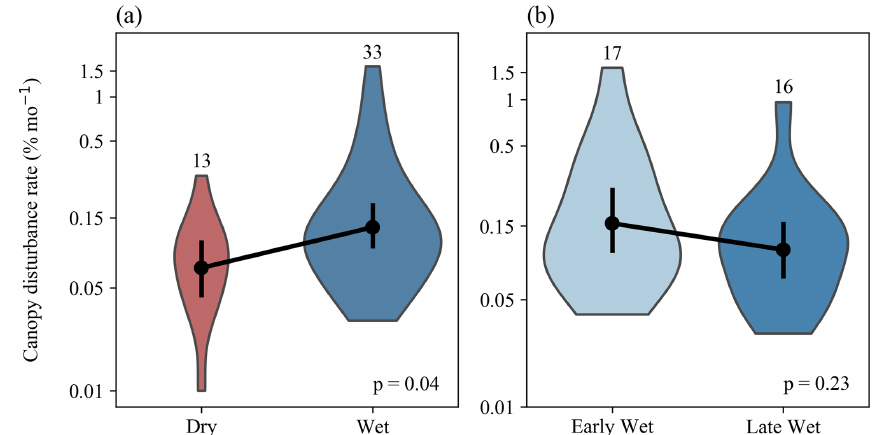
Figure 4. Comparisons of canopy disturbances rates between wet and dry seasons (a) and between early and late wet seasons (b) . Violin plots depict the distributions of disturbance rates (percentage of area disturbed per month) over time intervals, with the number of time intervals listed above each violin plot. Black dots and bars show mean and 95% confidence intervals, respectively; p values are based on two-tailed Student’s t tests for differences in log-transformed canopy disturbance rates between